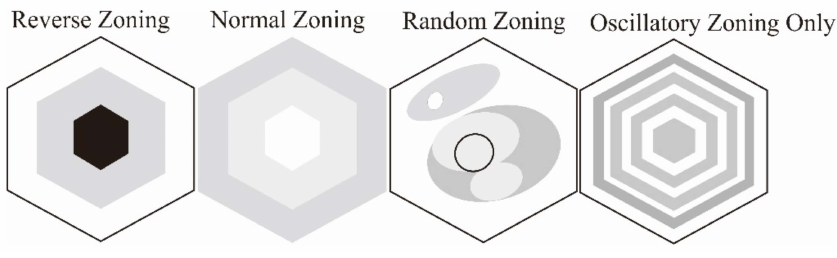
Figure 5. Four types of CL patterns observed from magmatic